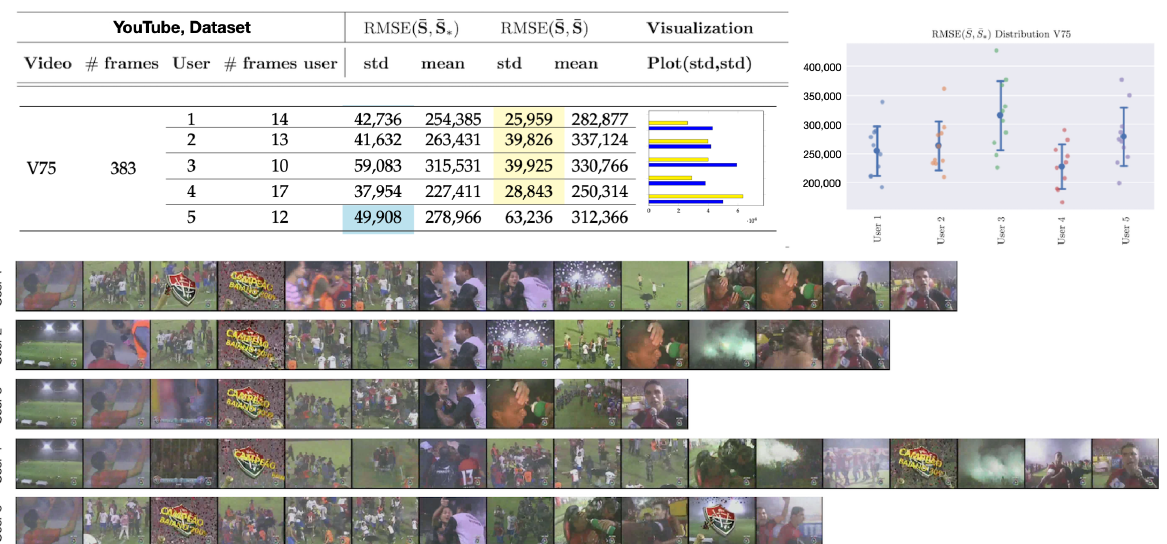
Figure 10. Visual depiction of human annotated summaries, together with RMSE ( ¯ S , ¯ S RMSE ( ¯ S , ¯ S ) of video V75, Table 4. Sampling rate: 1 frame per second. Highlighted values on the table correspond to the lowest standard